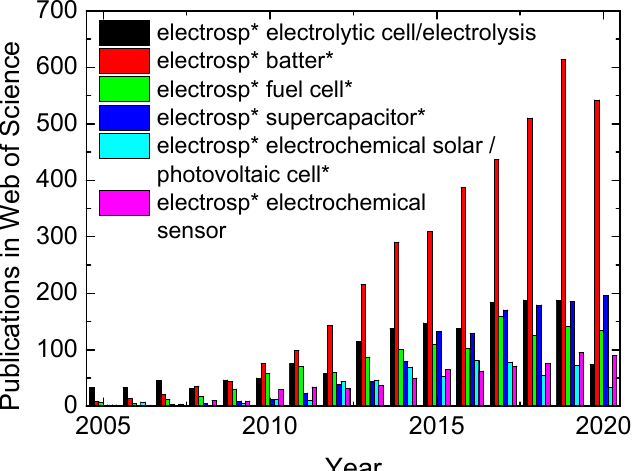
Figure 1. Publications reporting on electrospun nanofiber mats applied in electrochemical cells, found in the Web of Science during the last decades. Data accessed on 18 March 2021.